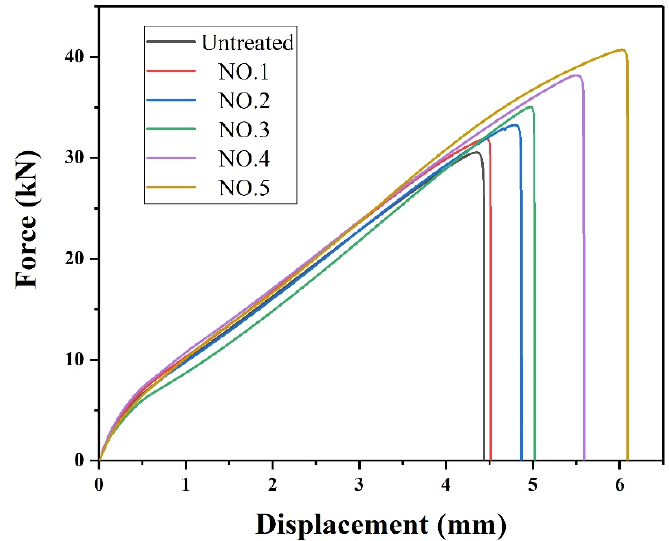
Figure 12. The stress-strain curves of the tested samples.